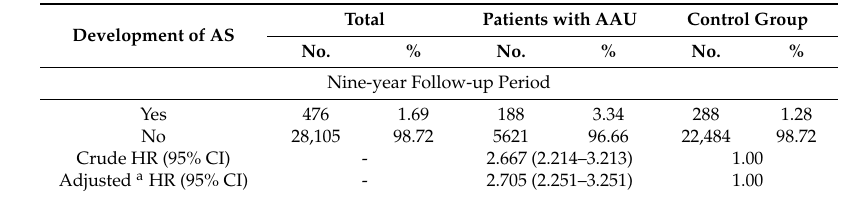
Table 2. Crude and adjusted hazard ratios for developing AS among patients with AAU and the control group during the ten-year follow-up (n = 28,105).